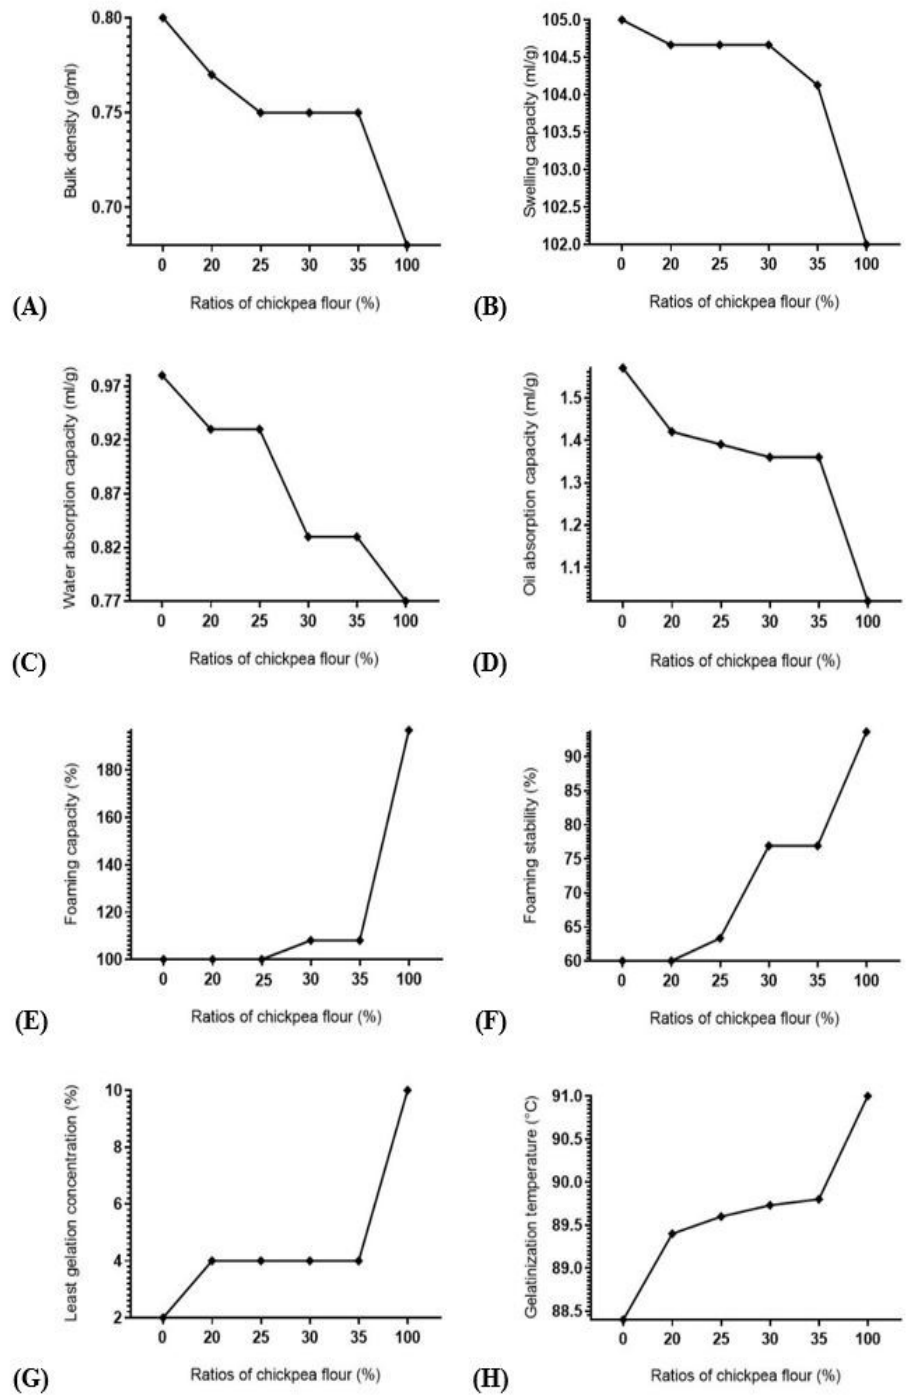
Figure 2. Functional properties values; ( A ): bulk density, ( B ): swelling capacity, ( C ): water absorption capacity, ( D ): oil absorption capacity, ( E ): foaming capacity, ( F ): foaming stability, ( G ): least gelation concentration and ( H ): gelatinization temperature of durum wheat flour, fortified durum wheat flour, and chickpea flour.